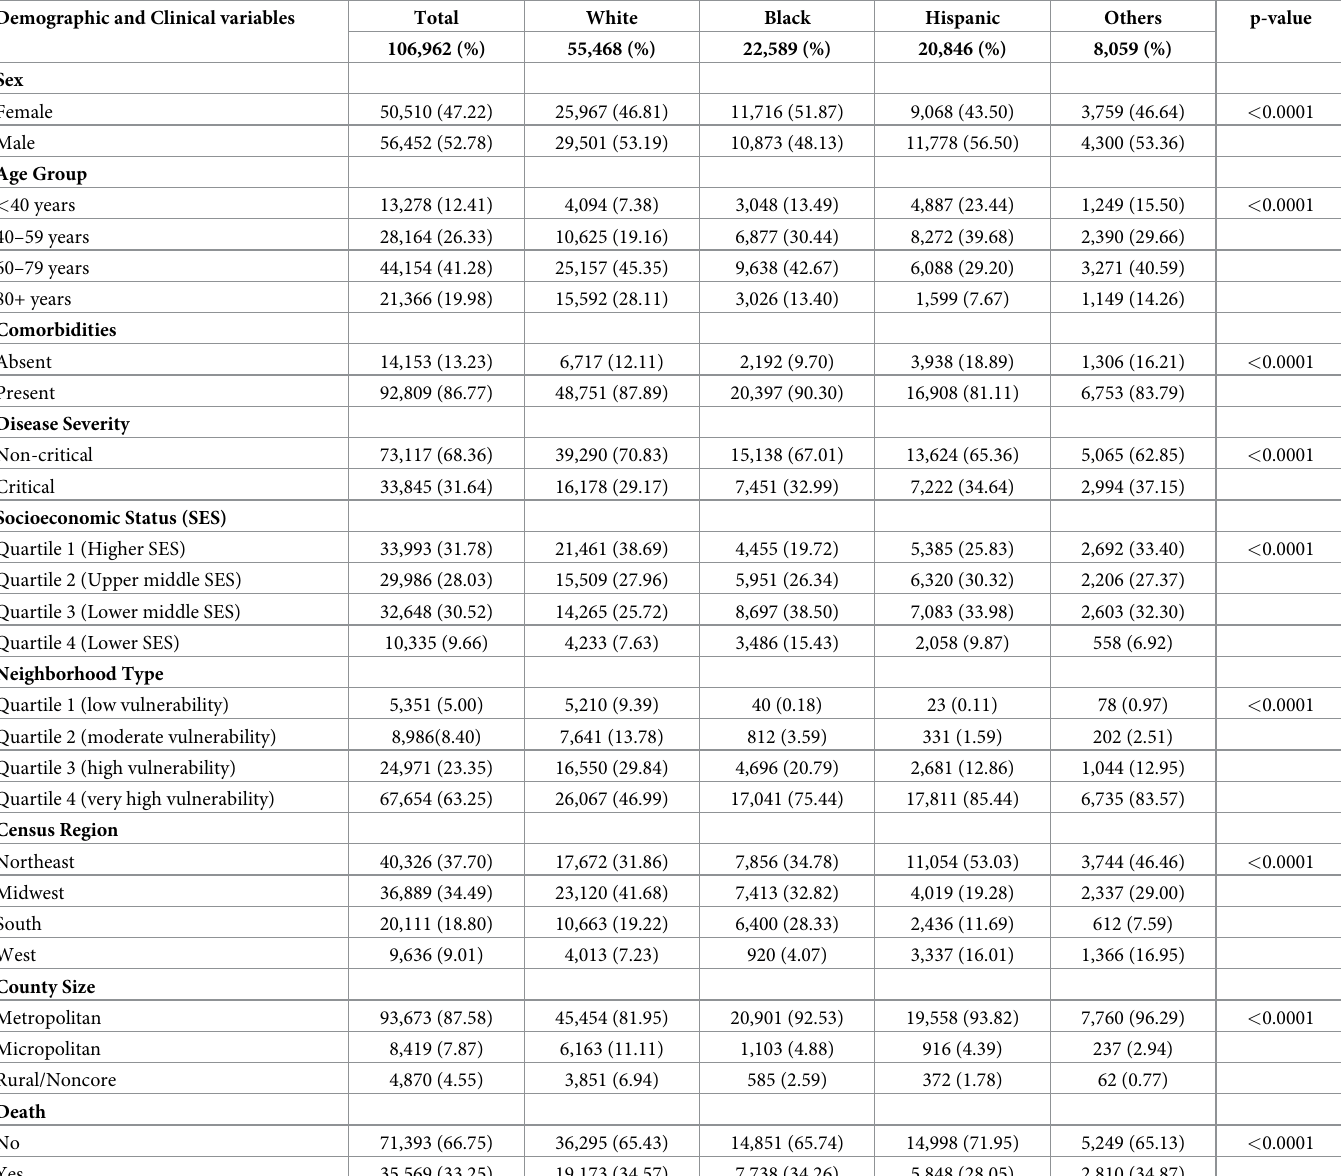
Table 1. Demographic and clinical characteristics of hospitalized COVID-19 patients by racial category (N = 106,962) for the complete case